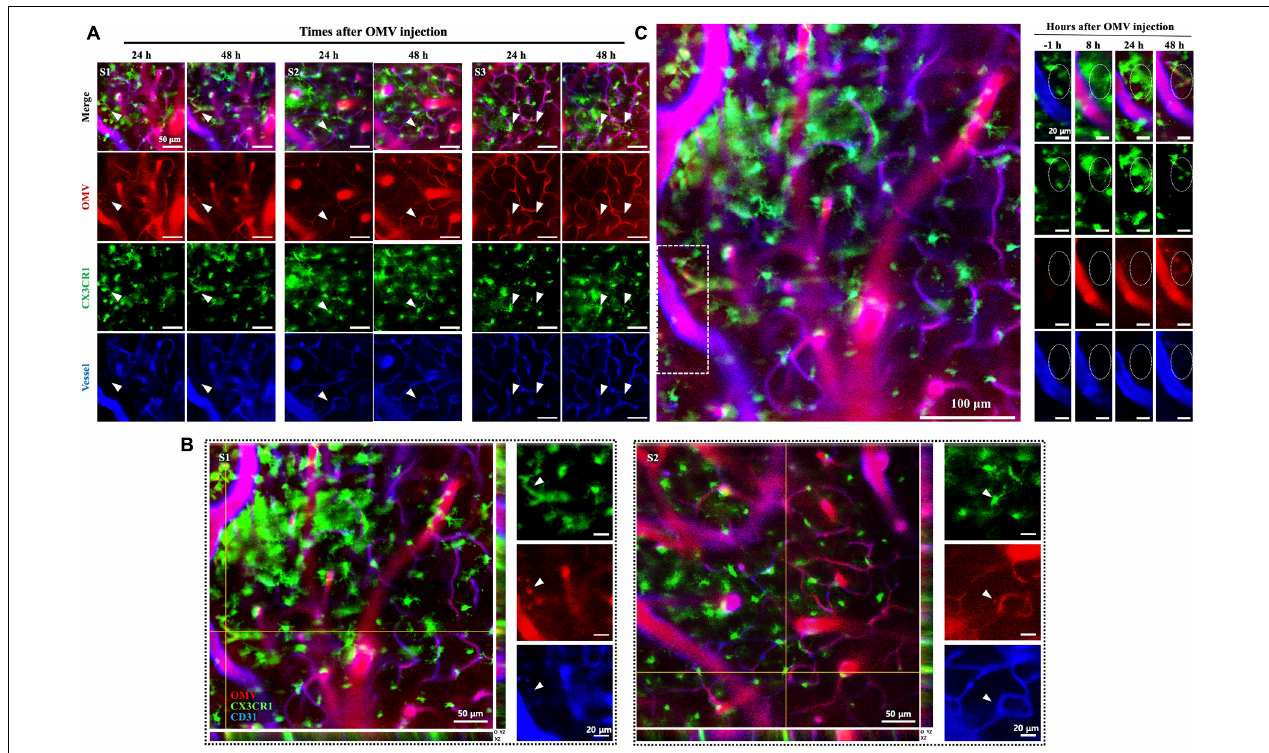
FIGURE 3 | Visualization of tail-vein-injected OMVs and microglial cells in the cortex of live CX3CR1-GFP mice. (A) OMVs taken up by microglial cells were imaged at 24 and 48 h after OMV injection. White arrowheads indicate OMVs taken up by microglial cells. Fluorescence-dye-conjugated anti-CD31 antibody was injected 1 h before imaging. Three different regions were captured. Scale bar: 50 µ m. (B) Representative image stacks (5 µ m intervals) acquired during confocal imaging of experimental mice with GFP-positive microglial cells for OMVs injected (48 h). The arrowheads refer to the colocalization of BBB-crossed OMVs (red) and CX3CR1-positive microglial cells (green) localized in the exterior of vessels. Scale bar: 50 µ m; magnified scale: 20 µ m. (C) Confocal microscopic acquisition results showing the OMV distribution before OMV injection (–1 h) and 8, 24, and 48 h after OMV i.v. injection of mice. The white dotted rectangle in the left panel was magnified. Right panel: magnified images of OMVs taken up by microglial cells (dotted circles). Scale bar: 100 µ m; magnified scale: 20 µ